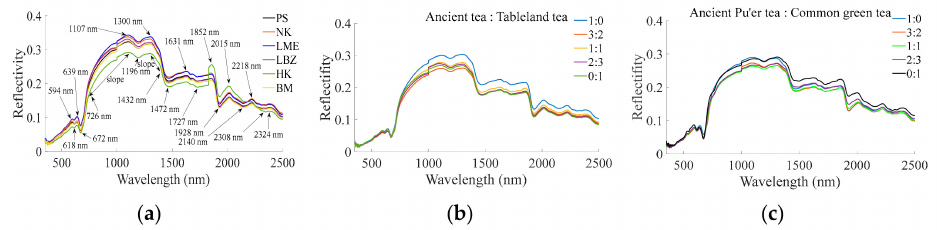
Figure 1. Average value comparison of tea sample in di ff erent ( a ) type; ( b ) blended ratio; ( c ) mixed ratio. The same feature extraction with ( a ) was also appliedforPu’re tea’s blended ratio and mixed ratio detection, and they were not marked in ( b , c )